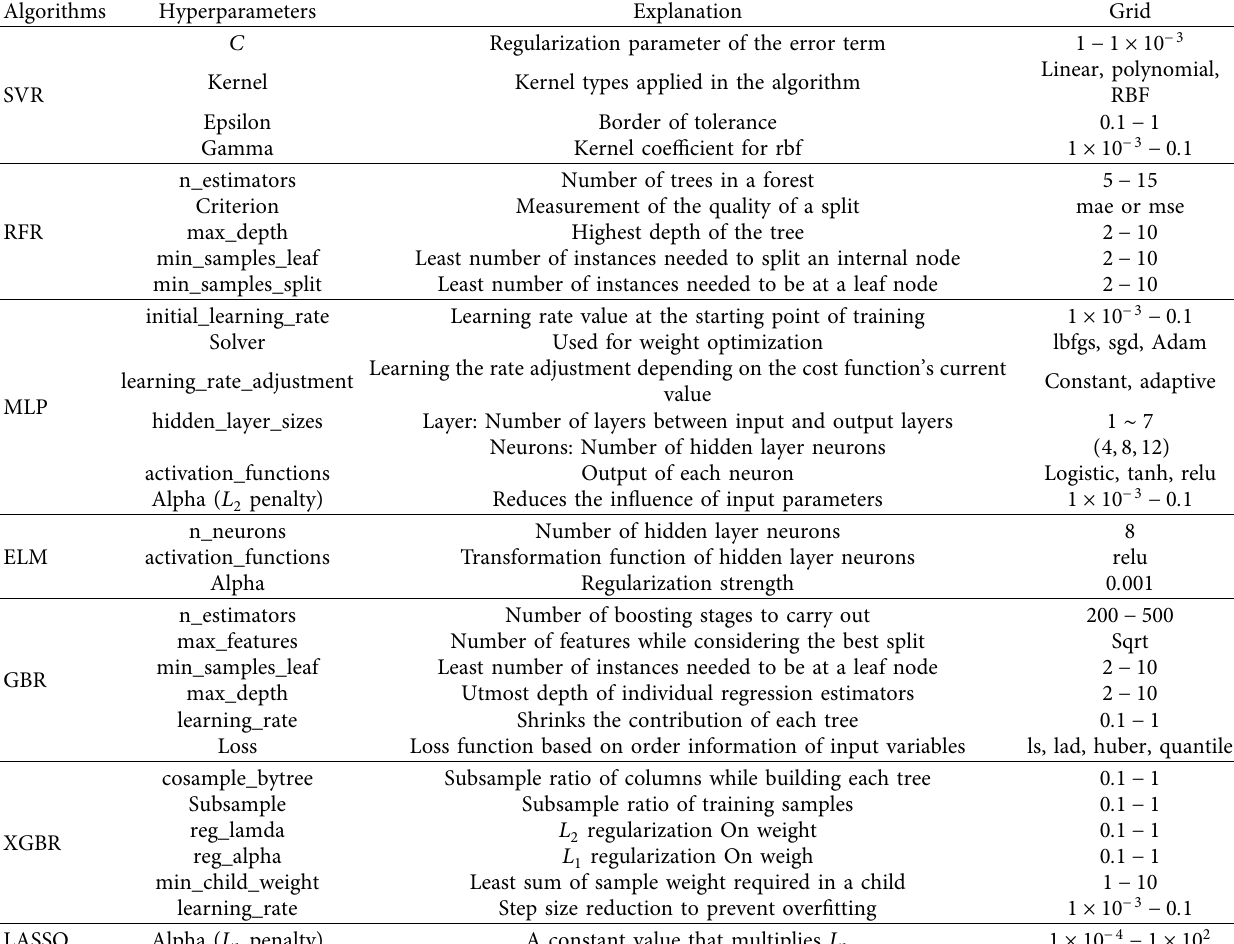
Table 3: Different machine learning techniques with hyperparameters to be tuned by the grid search algorithm during cross-validation.